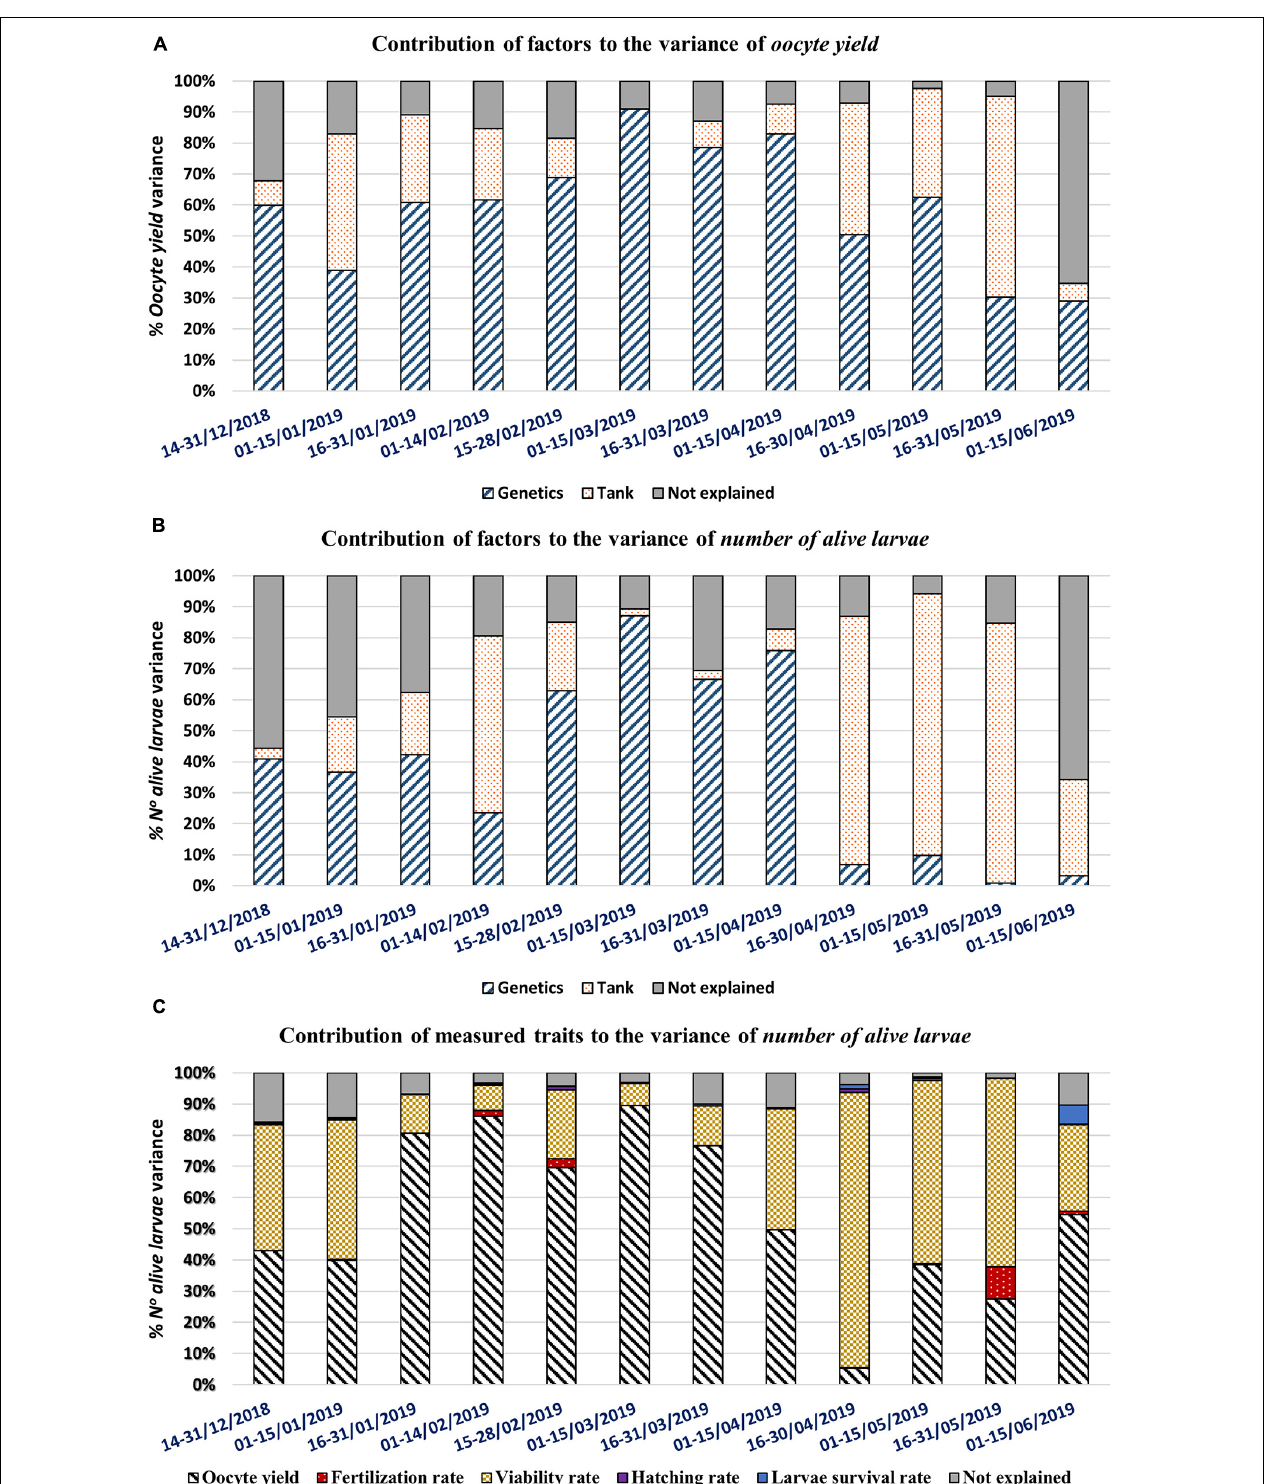
FIGURE 5 | Histograms of the variance explained in the linear regression analysis by fortnight, throughout the spawning season. Each capital letter represents a different analysis: (A) the importance of environmental and genetic factors (Tank and Genetic, respectively) on the oocyte yield . (B) The importance of environmental and genetic factors (Tank and Genetic, respectively) on the number of alive larvae . (C) The importance of measured traits ( oocyte yield, fertilization rate, viability rate, hatching rate, larval survival rate ) on the number of alive larvae.